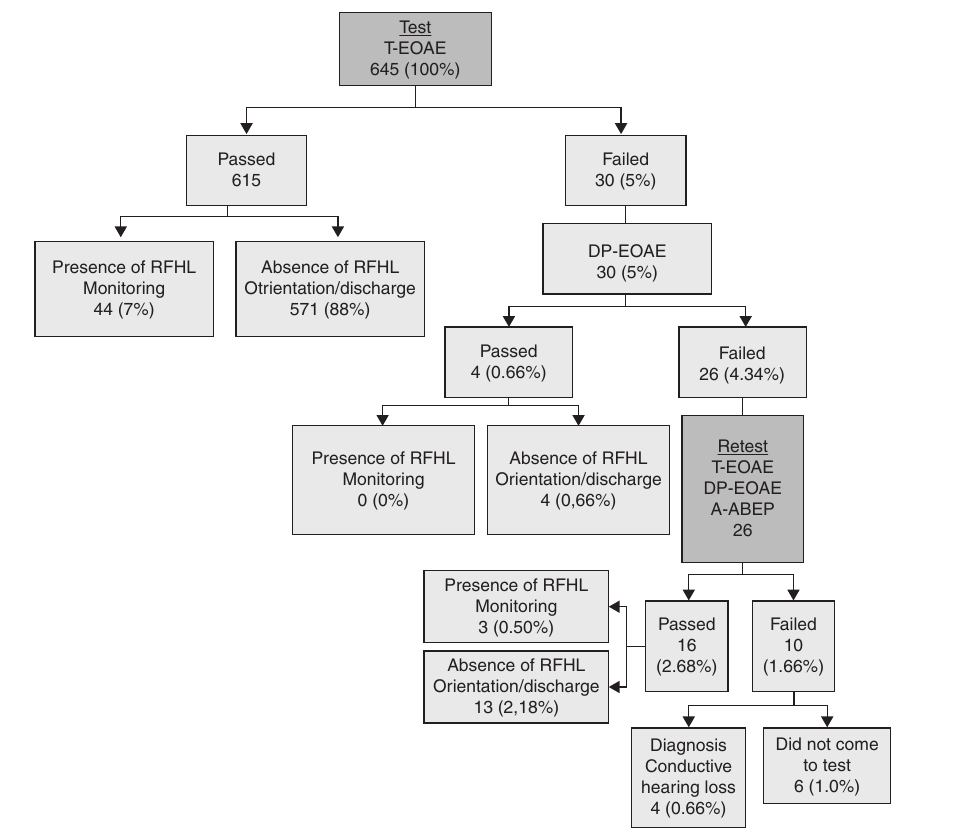
Figure 1 Flowchart. RFHL, risk factors for hearing loss; TEOAE, transient-evoked otoacoustic emissions; DPEOAE, distortion product-evoked otoacoustic emissions; A-ABEP, automated-auditory brainstem emission potential.